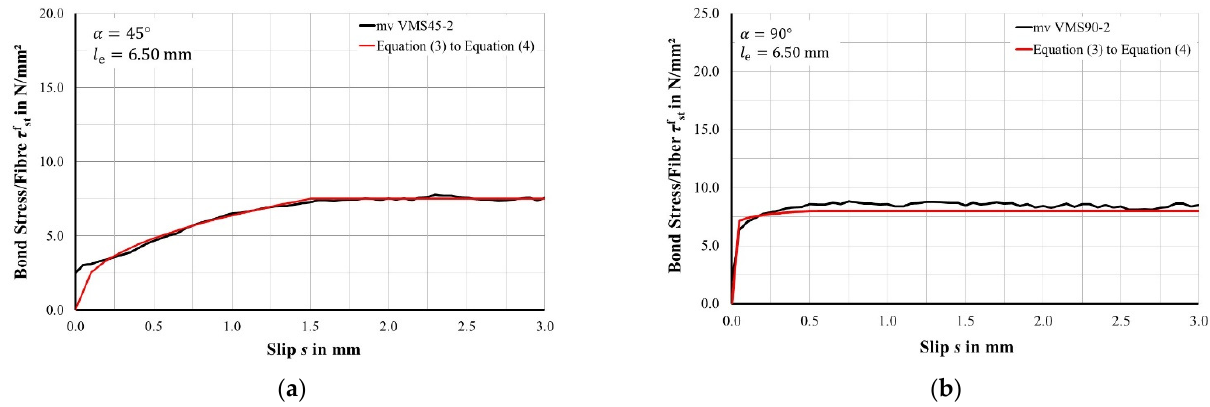
Figure 5. Experimental bond stress-slip relationship and analytical bond stress-slip relationship according to Equations (3) and (4): ( a ) Fibre orientation angle at 45° and ( b ) fibre orientation angle at 90°.